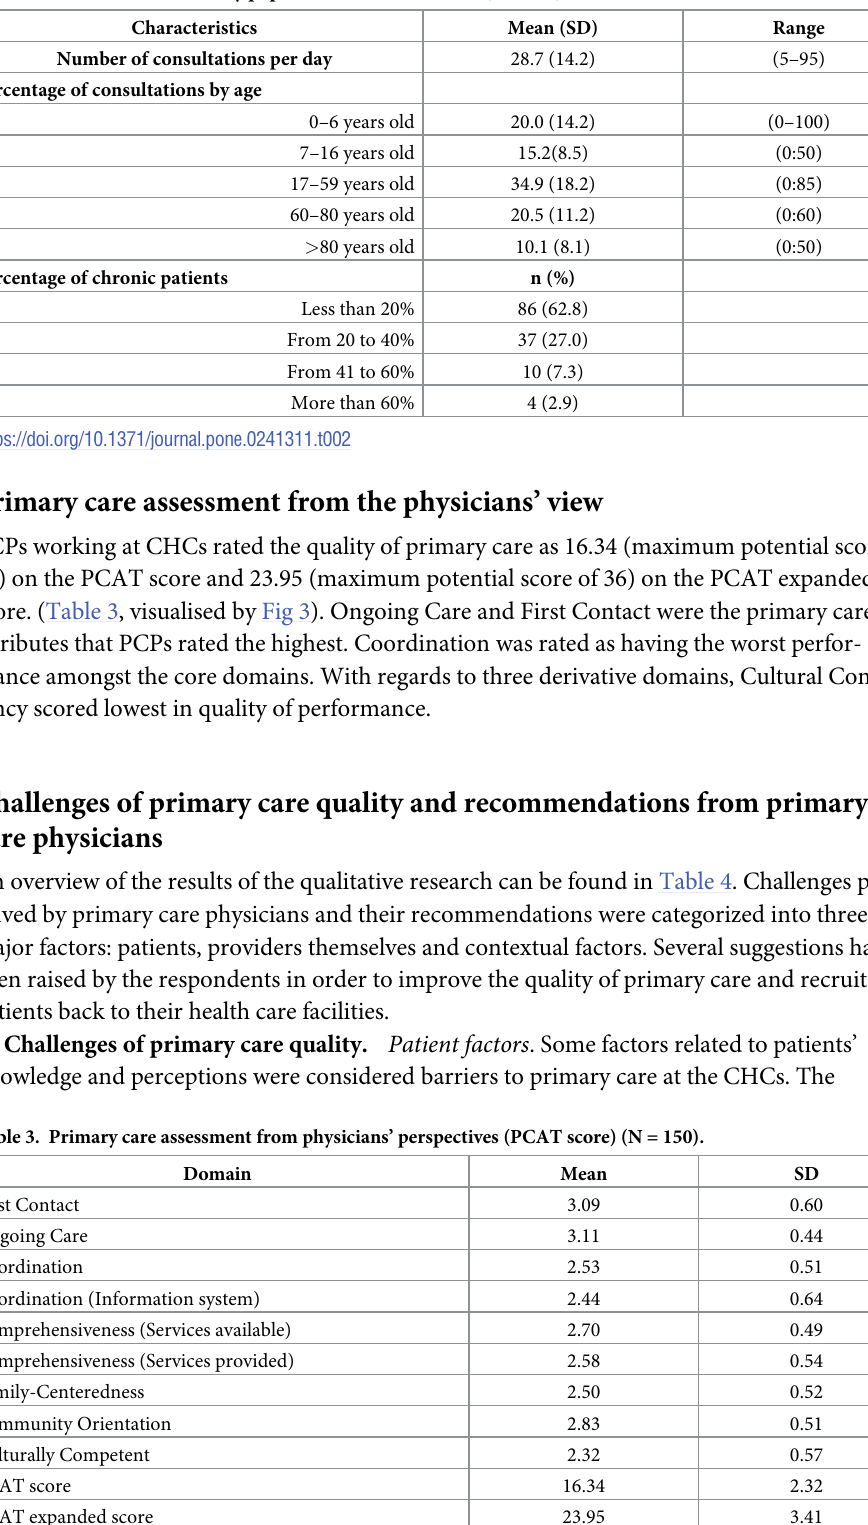
Table 2. Characteristics of study population: Health facilities (N = 150).